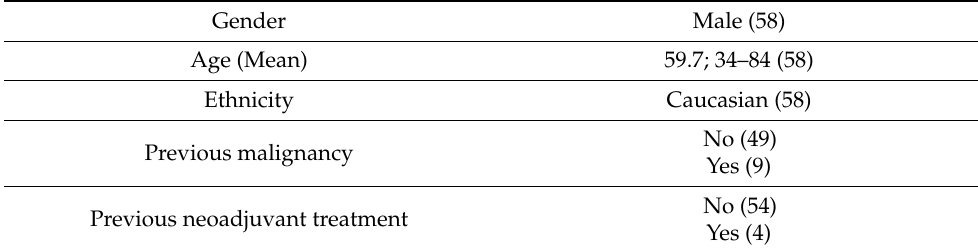
Table 2. Descriptive data of ccRCCp